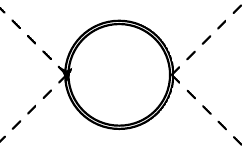
Figure 19. An example diagram in which neutral heavy particle loop contributes only a s-wave component. The resulting loop generator is likely to be an